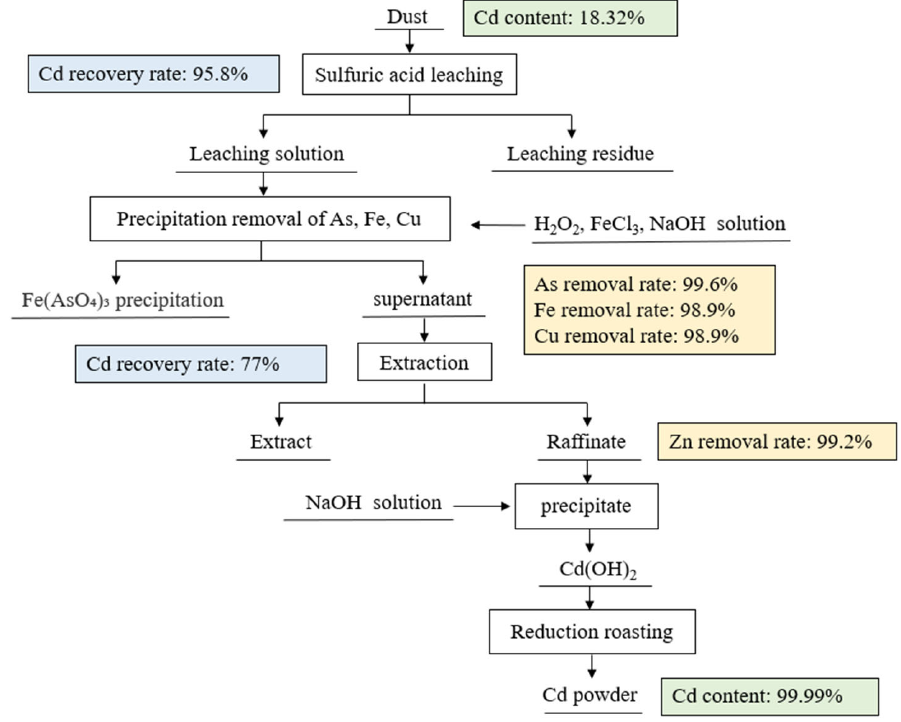
Figure 5. High purity Cd was prepared from the Cd-containing dust process by an acid leaching process, reproduced from [59], with permission from Elsevier, 2015.